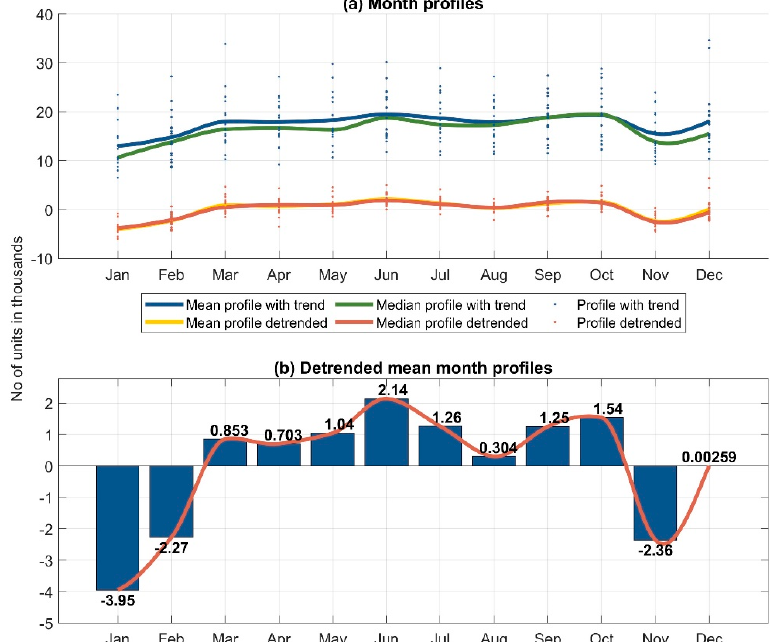
Figure 1. Averaged annual profile. Permits issued for construction—total (Source: own compilation based on data from CSO).